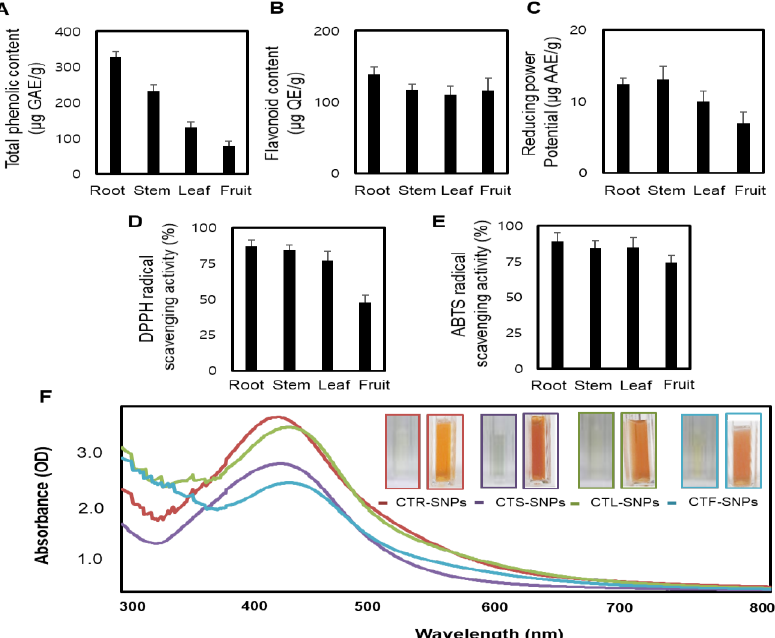
Figure 1. ( A ) Total phenolic content; ( B ) Flavonoid content; ( C ) Reducing potential; ( D ) DPPH radical scavenging activity; ( E ) ABTS radical scavenging activity of CTR, CTS, CTL, and CTF extracts; ( F ) Color change during synthesis (at 80 °C for 5 min) and UV-visible spectrum of CTR, CTS, CTL, and CTF-SNPs.